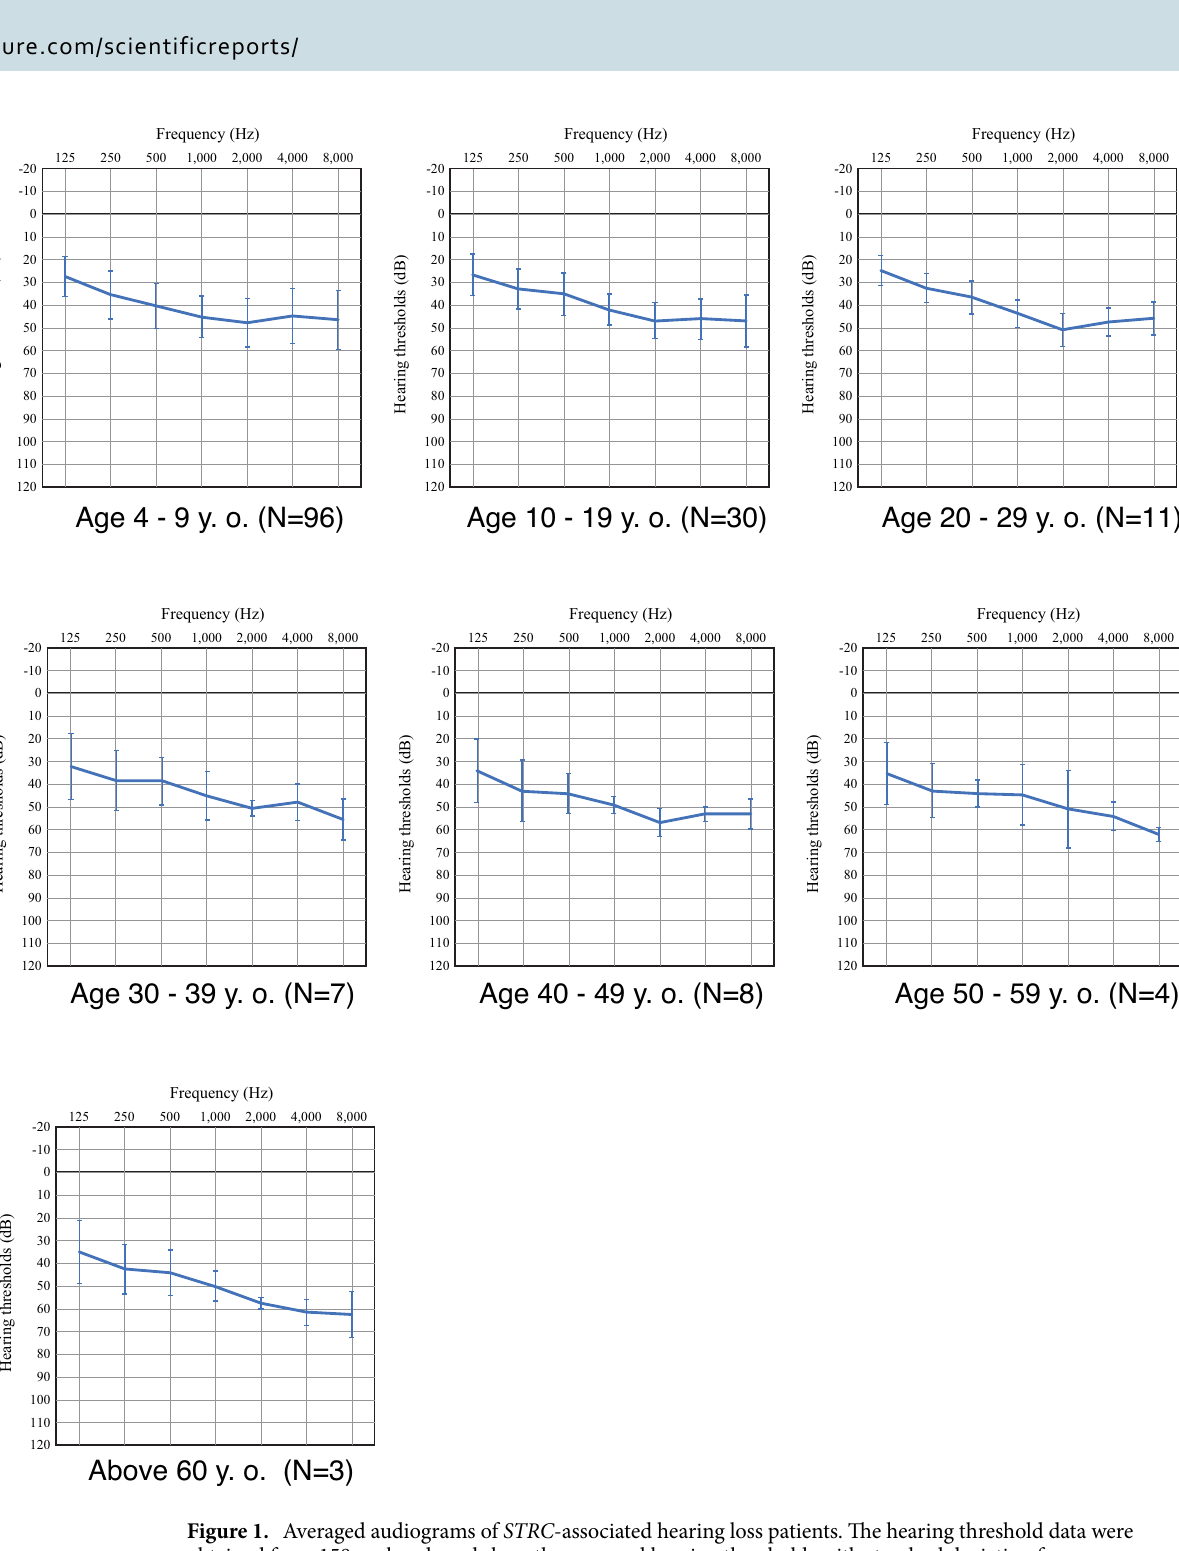
Figure 1. Averaged audiograms of STRC -associated hearing loss patients. The hearing threshold data were obtained from 159 probands and show the averaged hearing thresholds with standard deviation for every 10 years of